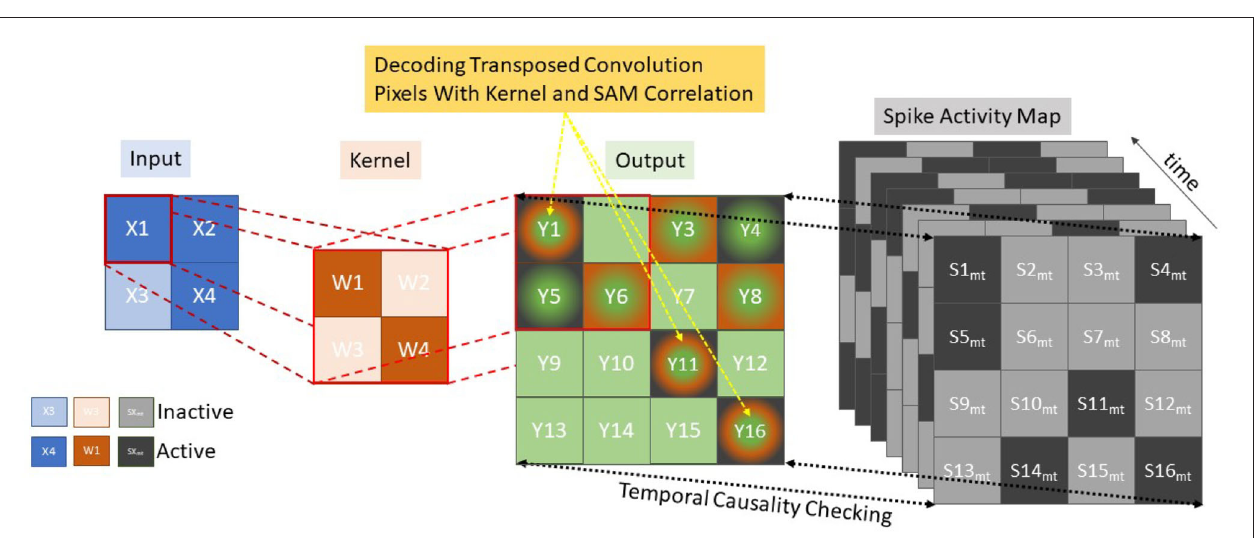
FIGURE 2 | Input event streams from N-Caltech Dataset “Face,” with (A,B) showing a 10 ms clip over 10 steps going from left to right. (A) Showing the input to the network per step and (B) showing the accumulated inputs for easier visualization. (C,D) Show a 10 ms clip over 10 steps with additive noise to show how extra noise affects the input stream, with (C) showing per step and (D) showing accumulated.